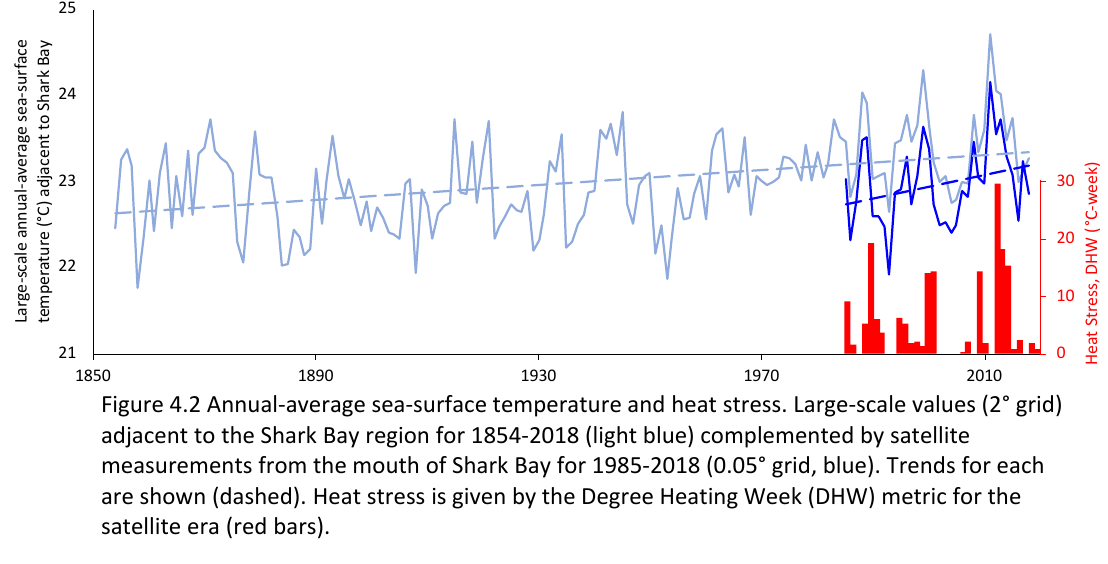
Figure 4.2 Annual-average sea-surface temperature and heat stress. Large-scale values (2° grid) adjacent to the Shark Bay region for 1854-2018 (light blue) complemented by satellite measurements from the mouth of Shark Bay for 1985-2018 (0.05° grid, blue). Trends for each are shown (dashed). Heat stress is given by the Degree Heating Week (DHW) metric for the satellite era (red